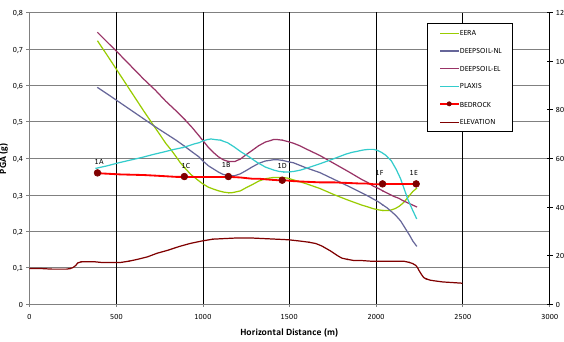
obtained. For the one dimensional analysis, the EERA and DEEPSOIL (equivalent linear (EL) and nonlinear (NL)) programs were used and the PLAXIS 8.2 finite element program was used for the two-dimensional analyses. For all the sections, the change of the maximum surface acceleration on the ground surface is shown together with the change of peak acceleration value belonging to the bedrock as shown in Figures 10 to 14.